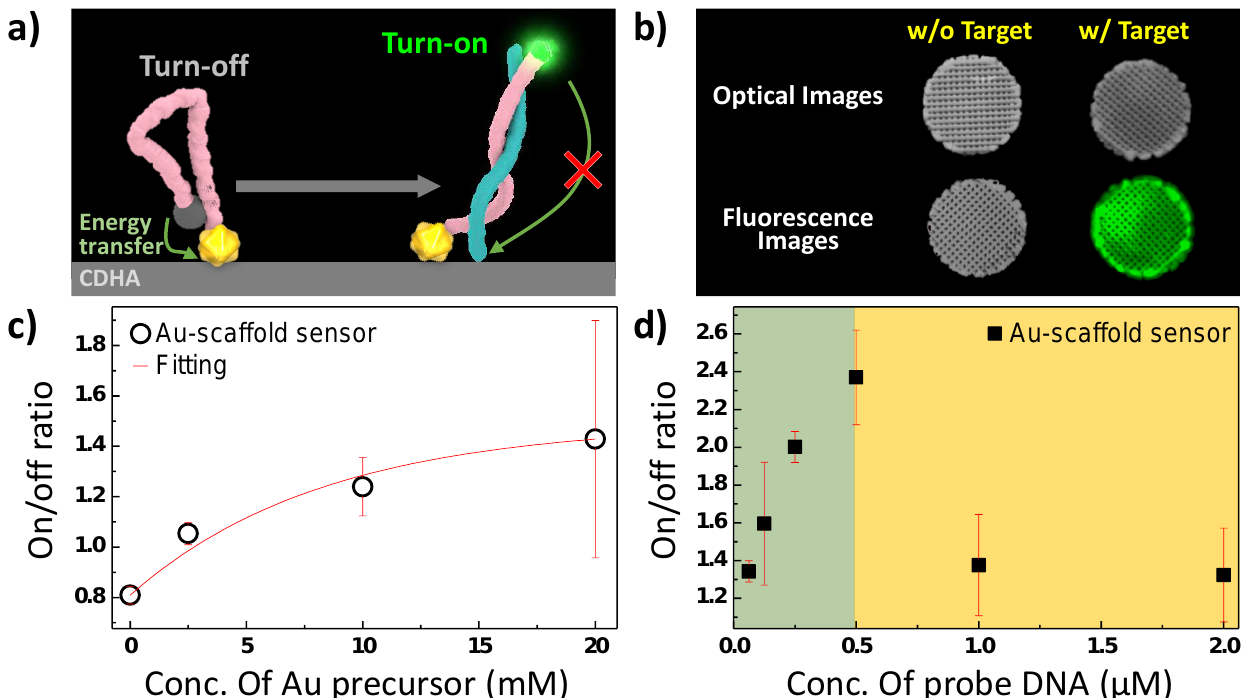
Figure 3. Optimization of the FRET system of Au-scaffold sensor. ( a ) Schematic illustration for the detection of target oligonucleotide on Au-scaffold sensor. ( b ) Fluorescence imaging of Au-scaffold sensor w/ and w/o of target treatment. ( c ) The ratio of PL turn on / turn off signal of Au-scaffold sensor as a function of Au NPs concentration and ( d ) FAM-labeled probe DNA.